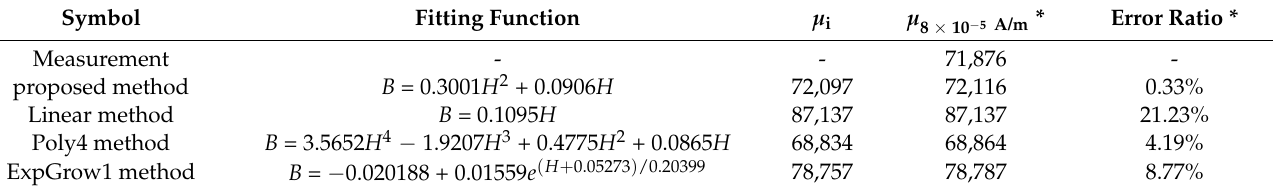
Table 3. Comparison of four methods and the measurement